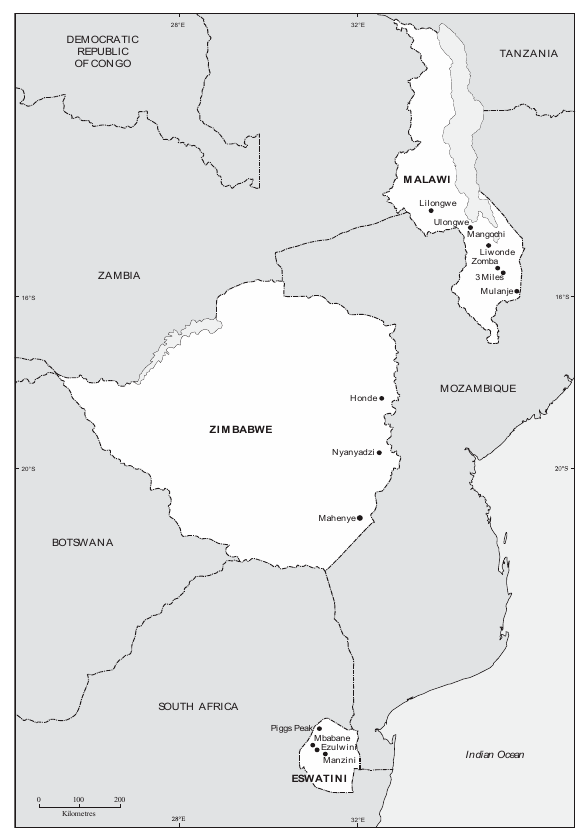
Figure 1. The location of the study sites in Eswatini, Malawi and Zimbabwe.